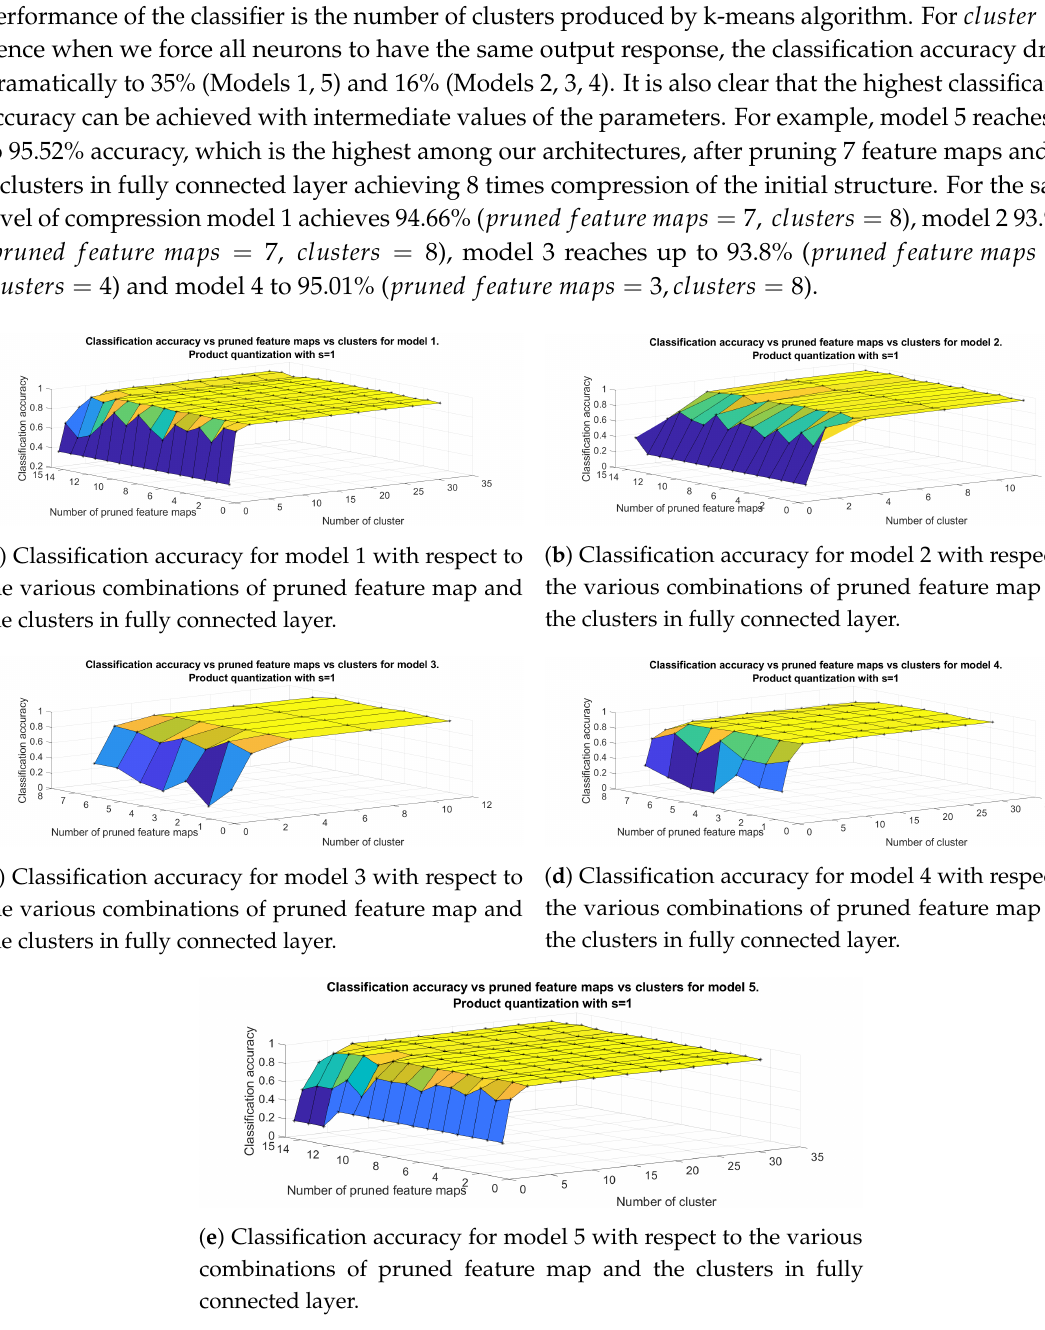
Figure 8. Classification accuracy for models in Table 1 for the approach that include filter pruning and product quantization with s =